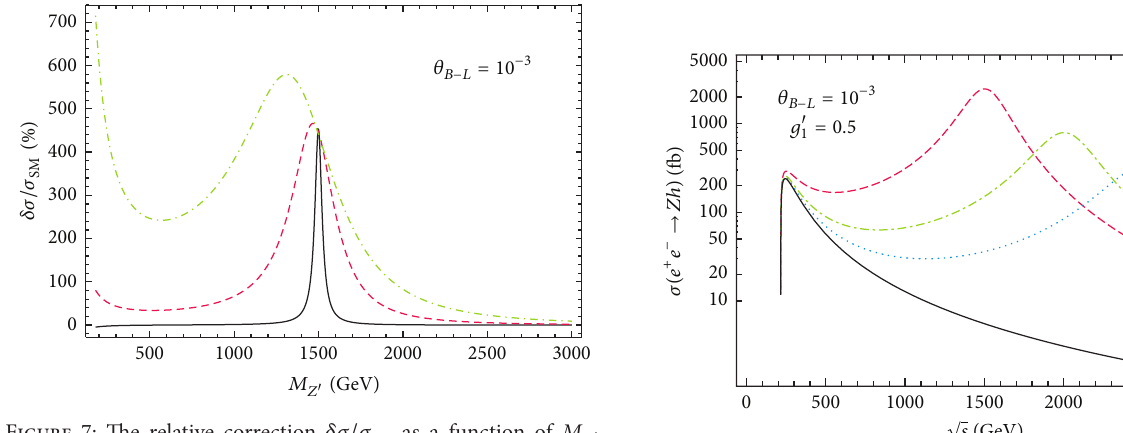
Figure 7: The relative correction 𝛿𝜎/𝜎 SM as a function of 𝑀 𝑍 󸀠 . Starting from the bottom the curves are for 𝑔 󸀠 1 = 0 . 2 , 0 . 5 , 0 . 8 GeV and √𝑠 = 1500 GeV, respectively.